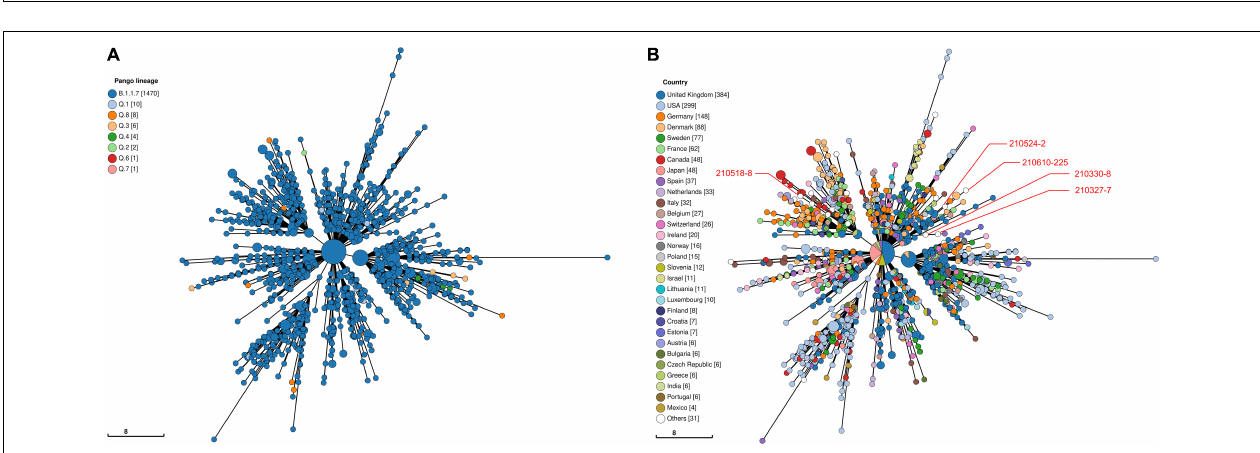
FIGURE 4 | Haplotype network analysis using genome-wide single-nucleotide variations of 42 SARS-CoV-2. It represents genetic relationship or distances between 42 isolates of SARS-CoV-2. The colors represent different lineages. The numbers show genetic distances in SNP differences. SNP, single nucleotide polymorphism.